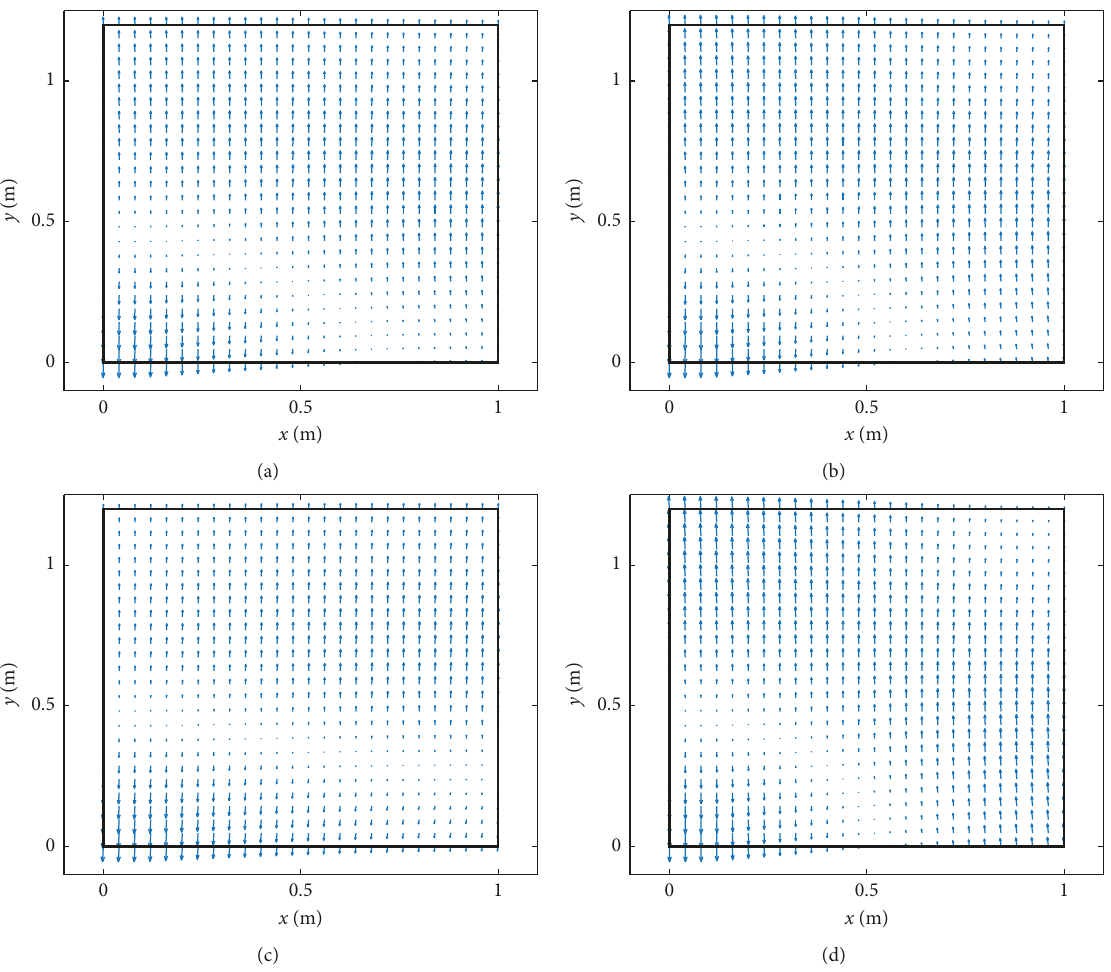
Figure 6: Acoustic velocity vectors at the top surface of the cavity at 270Hz. (a) Reference method. (b) Hybrid SFEM. (c) NS-FEM. (d) FS- FEM.